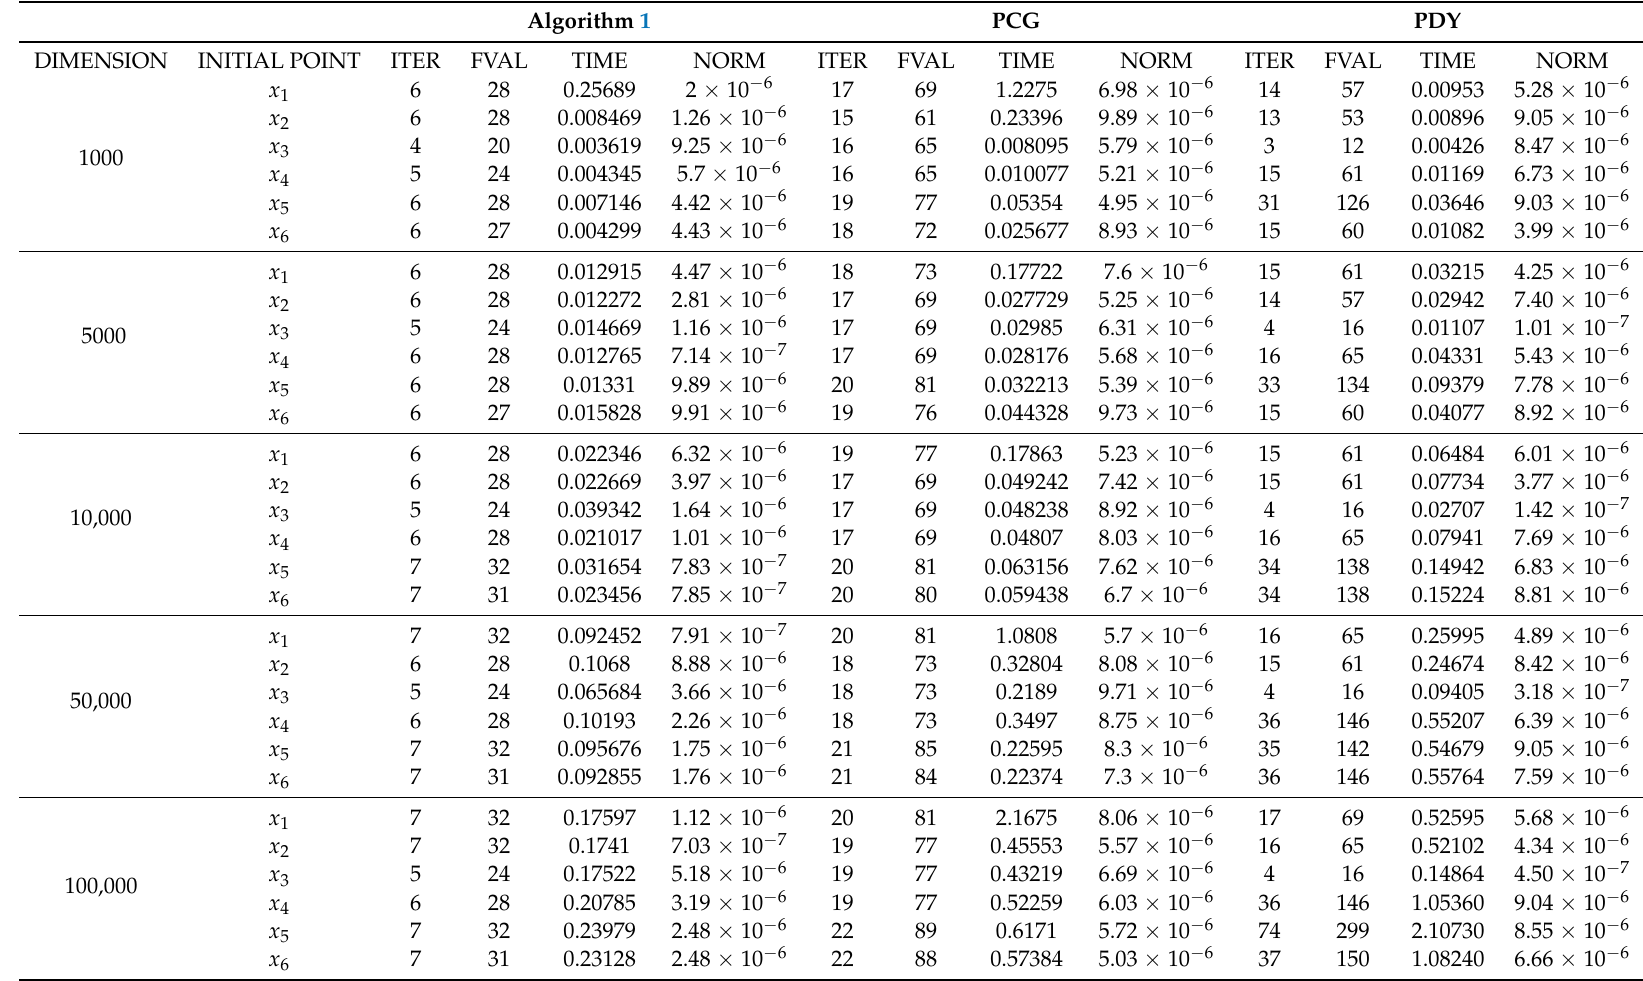
Table 7. Numerical Results for Algorithm 1 (DCG) , PCG and PDY for Problem 7 with given initial points and